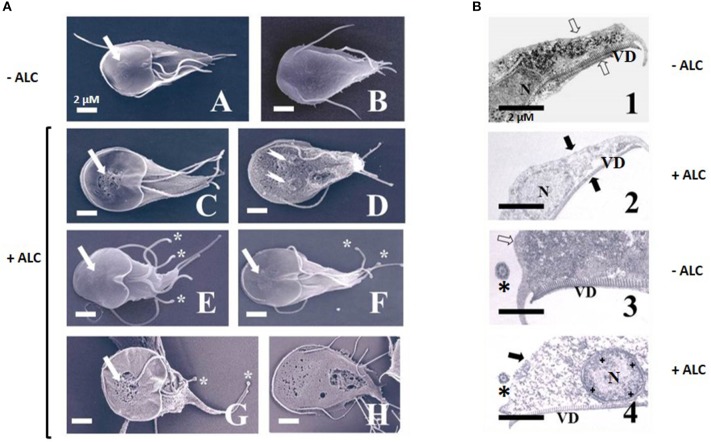
Analysis by scanning (A) and transmission (B) electron microscopy of G. duodenalis trophozoites exposed to allicin. (A) Parasites (1 × 106) were either not exposed (A,B) or exposed to 600 μM ALC (C–F) for 24 h or 1.2 mM ALC for 3 h (G,H) at 37°C. Trophozoites are shown in ventral (A,C, E–G) and dorsal (B,D,H) views. The higher roughness of cell surface in images C–H as compared to A,B, except over the ventral disk, are indicative of a degree of membrane blebbing. Arrows denote the so-called “bared area” of the ventral disk and asterisks point to tip rounding at flagella. (B) Parasites not exposed (1, 3) and exposed to 600 μM ALC (2, 4) for 24 h at 37°C. Trophozoites are shown in longitudinal (1, 2) and cross-sections (3, 4). Arrows indicate the plasma membranes, asterisks show flagellar axonemes and crosses show inner peripheral areas of nucleus with chromatin condensation. N, nuclei; VD, ventral disk. Bars correspond to the indicated size.